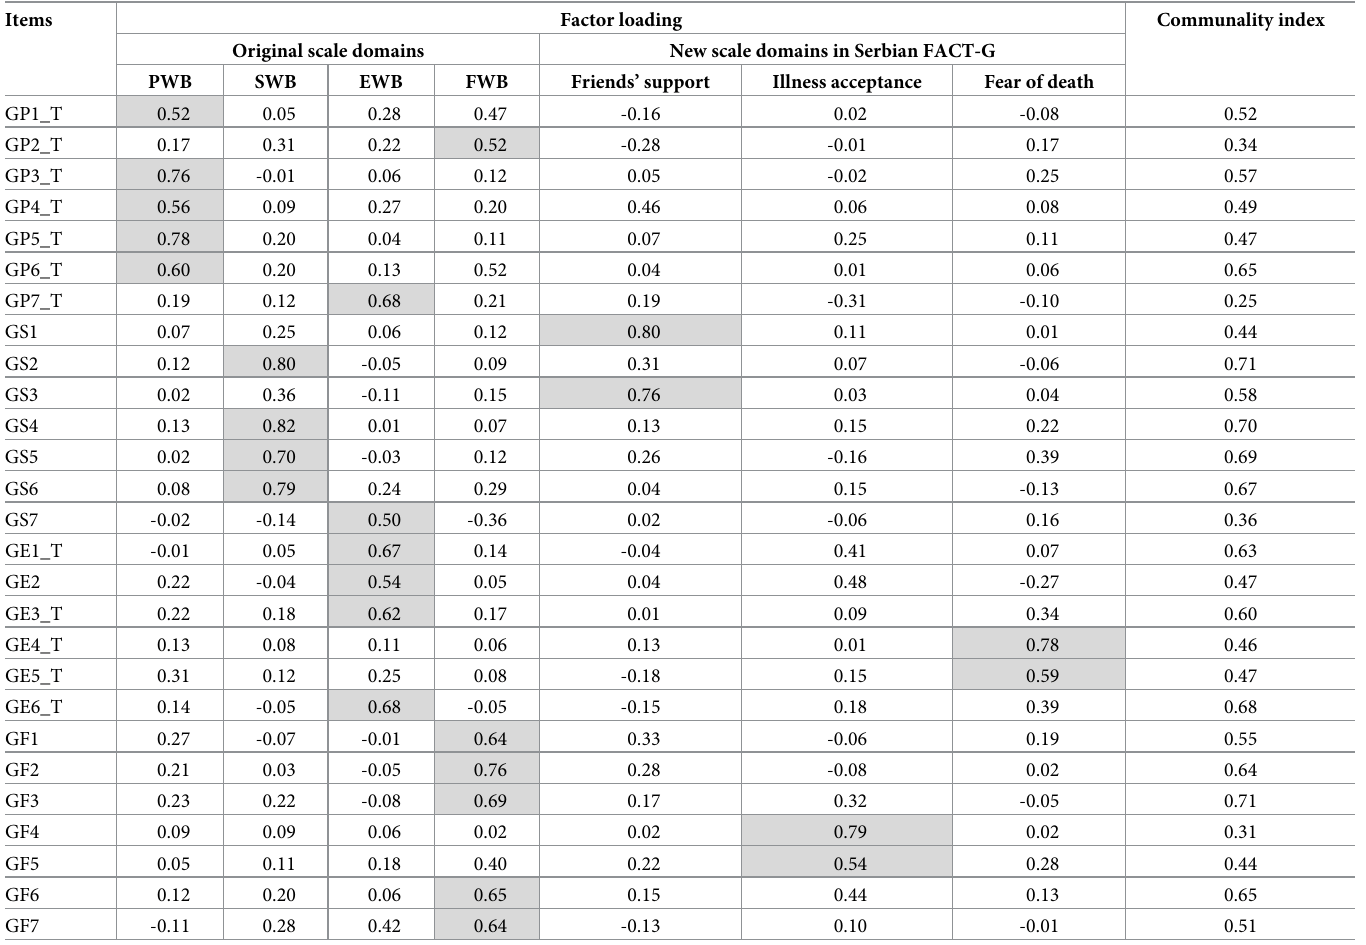
Table 3. Correlation coefficients of the FACT-G subscale items of the FACT-M and factors extracted after Varimax rotations in EFA.